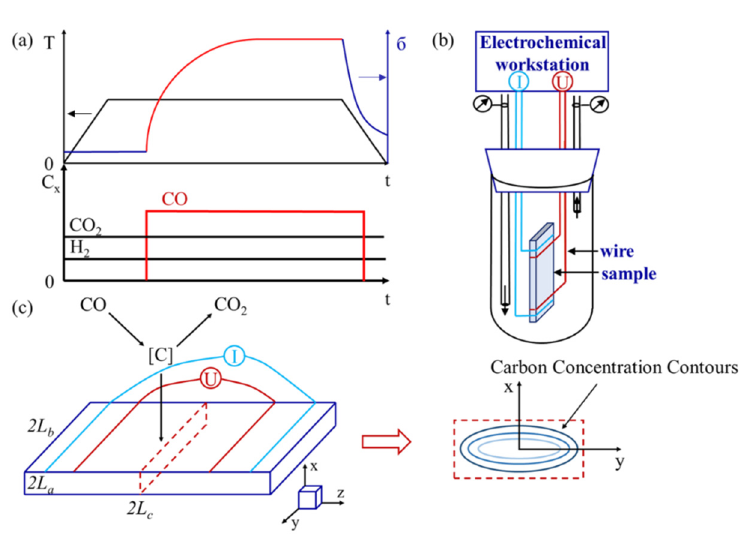
Figure 1. Schematic diagram of gas carburization process and the experimental setup. ( a ) flow dia- gram of gas carburizing process, ( b ) schematic diagram of the experimental setup, ( c ) schematic diagram of the experimental principle.